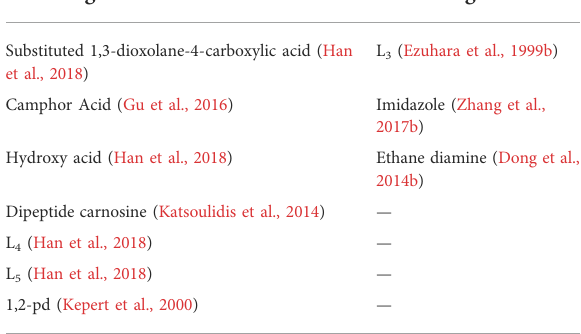
TABLE 1 List of some chiral and achiral ligands.